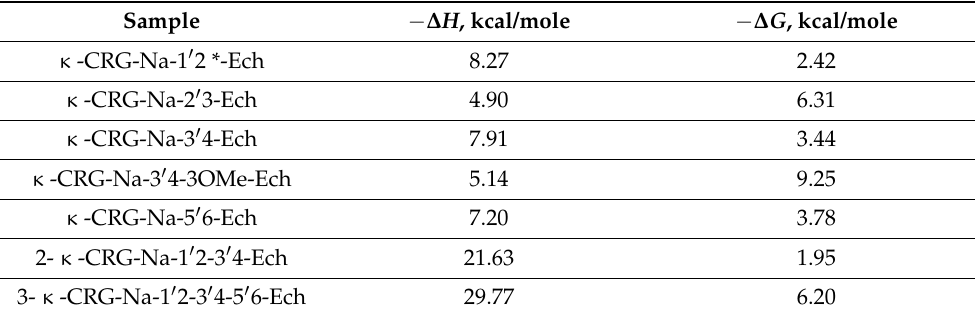
Table 2. Enthalpy ( ∆ H ) and Gibbs energy ( ∆ G ) of complexes of Ech with κ -CRG. Sample − ∆ H , kcal/mole − ∆ G ,